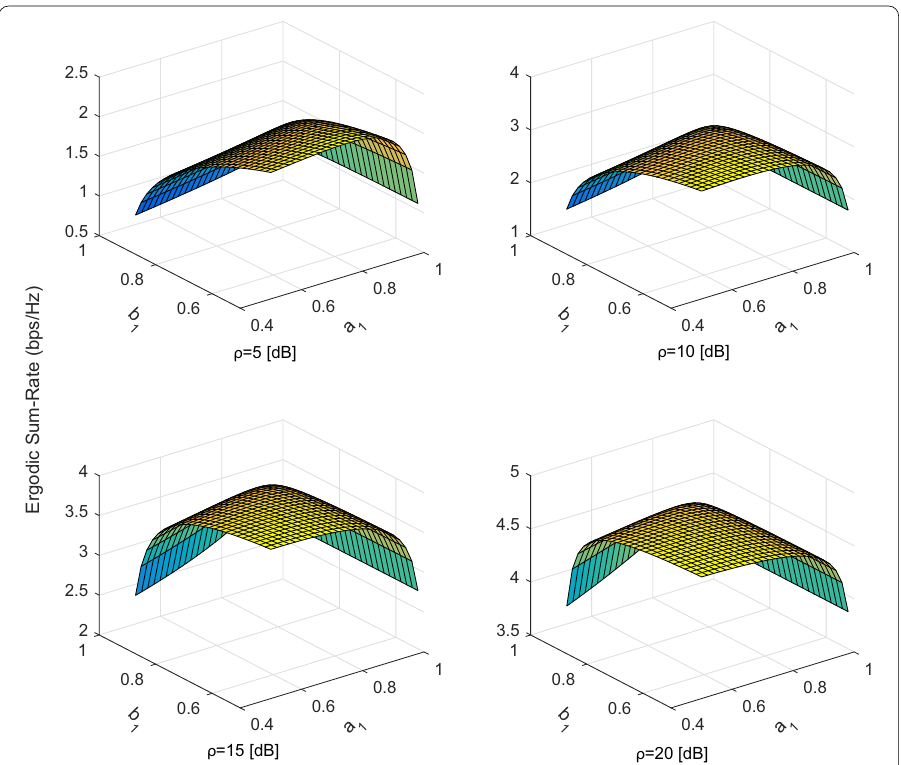
Fig. 4 The ergidic SR of the overlap case for our proposed NOMA-IoV system versus the power allocation factors a 1 and b